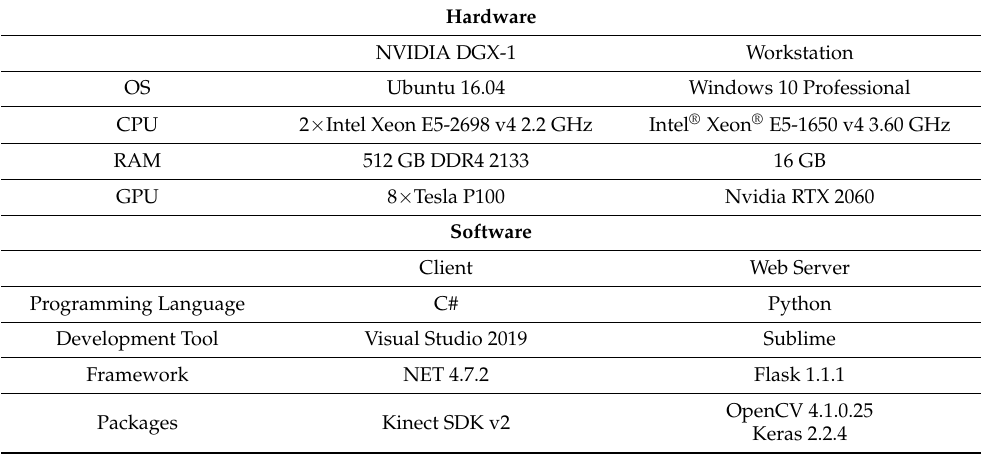
Figure 11. The proposed system prototype of food recognition for the Bento buffet: ( a ) the prototype contains an angle steel shelf, a Kinect camera, a light source, and a desktop computer; ( b ) Kinect Xbox One sensor. Table 2. The environment contents of hardware and software in our